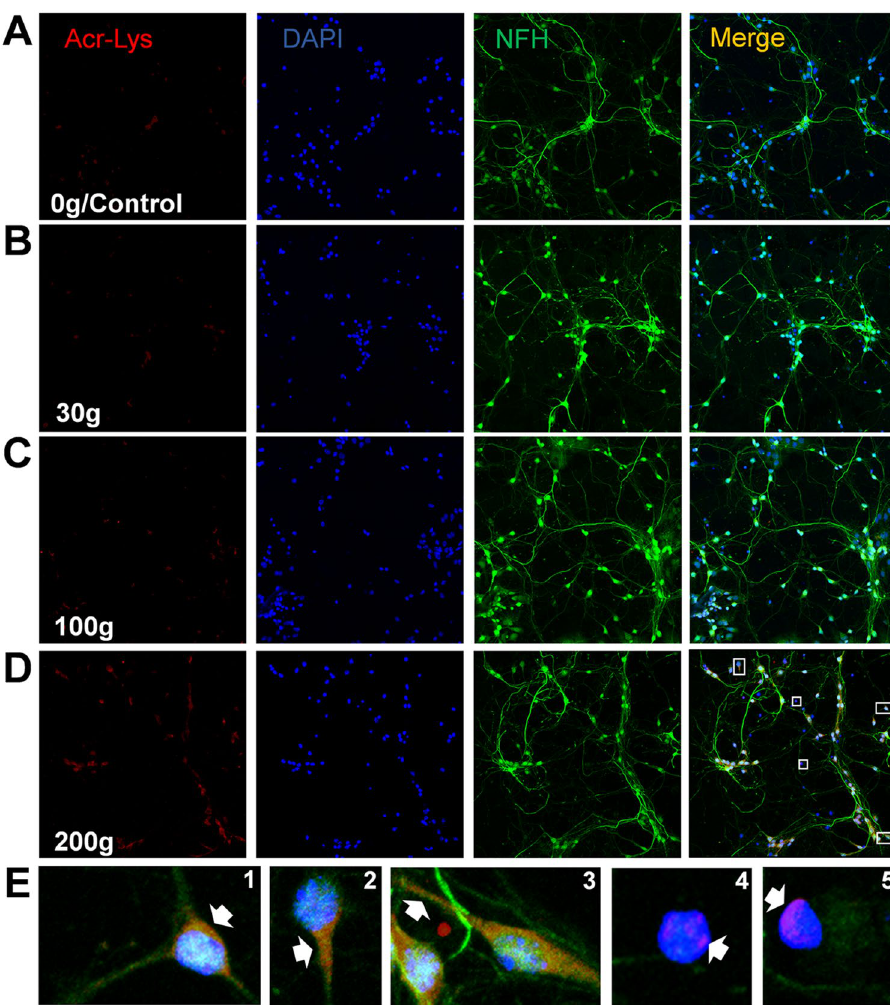
Figure 2. Visualizing the elevation of acrolein-Lys adducts as a function of single-impact severity. Representative fluorescence images at ×20 magnification are shown for histiotypical networks that received single impact forces of ( A ) 0 (control), ( B ) 30 g, ( C ) 100 g, ( D ) and 200 g. Nuclei are visualized with DAPI (blue), neuronal cell bodies and processes with neuron specific Neurofilament (green), and acrolein-Lys adducts with Stressmarq (red). Levels of acrolein-Lys adducts (red) progressively increase with larger g forces, moving top-to-bottom ( A – D ). Images demonstrating the spatial distribution of acrolein elevation are shown in both neuronal (E1-3) and non-neuronal cells (E4-5) which are enlarged from the (D)-merge series (200 g impact). Note the effective labeling of these antibodies, with the clear majority of all fluorescence being associated with cells, accompanied by very little background noise from our substrate and media. Further, these results suggest that all cells in our histiotypical cultures, both neuron (E1-3) and non-neuron (i.e. glia, E4&5), show increases in acrolein production, participating in the pathological consequences. However, most acrolein production appears to be perinuclear, with the majority localized in cell bodies (E1,4,5). While diffusion into cellular processes is observed (E2&3), it seems to be much less